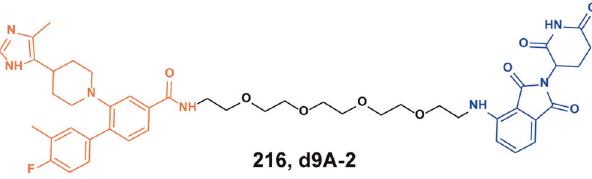
Fig. 69 The representative PROTAC targeting